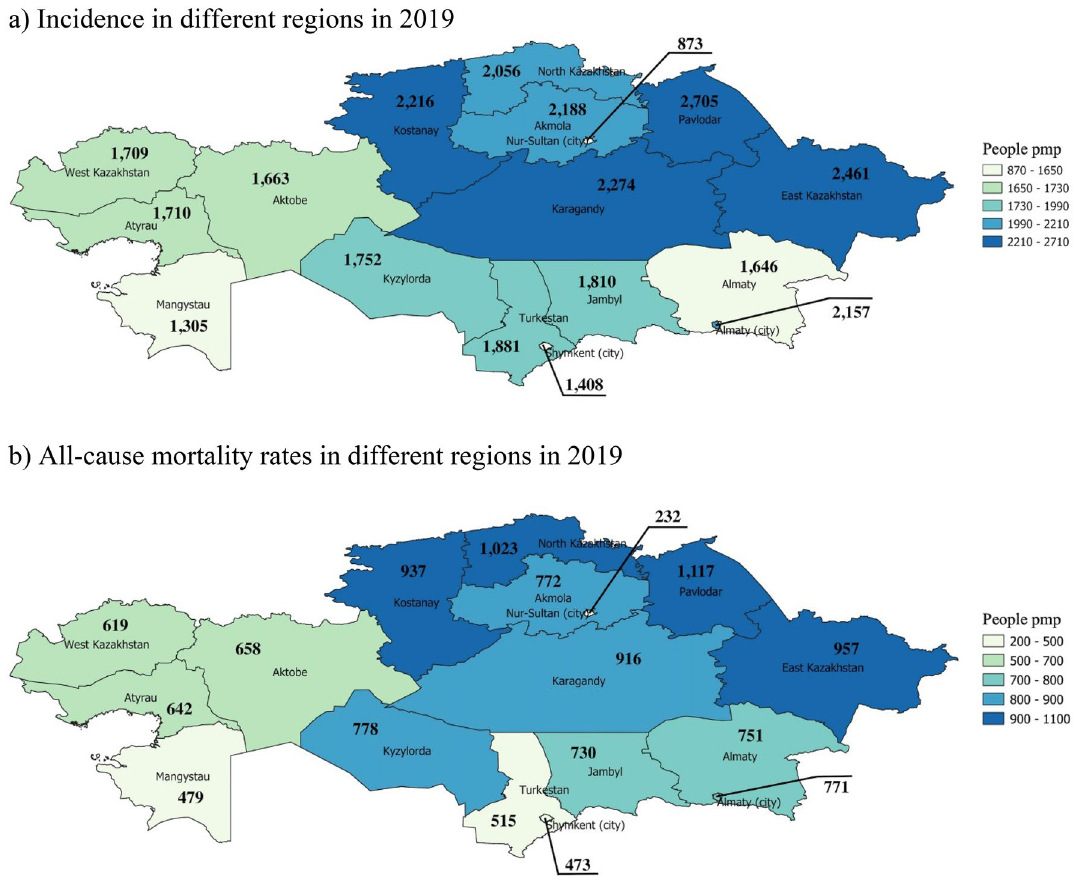
Figure 3. Incidence and all-cause mortality of stroke patients in Kazakhstan based on admission and discharge in 2019 (maps were generated using QGIS 3.16.11 Hannover version. URL: https:// www. qgis. org): ( a ) Incidence in different regions in 2019 ( b ) All-cause mortality rates in different regions in